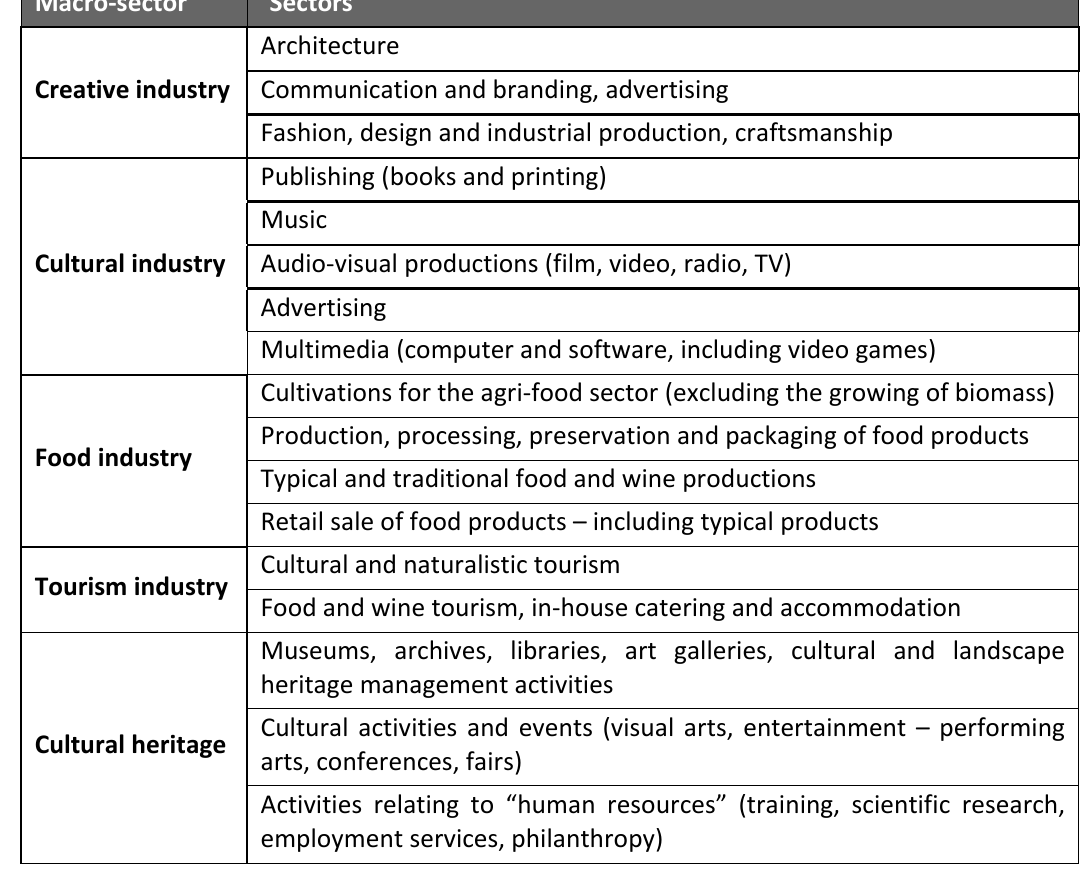
Table 3: Statistical framework in the study: breakdown of CCIs in macro-sectors and sectors